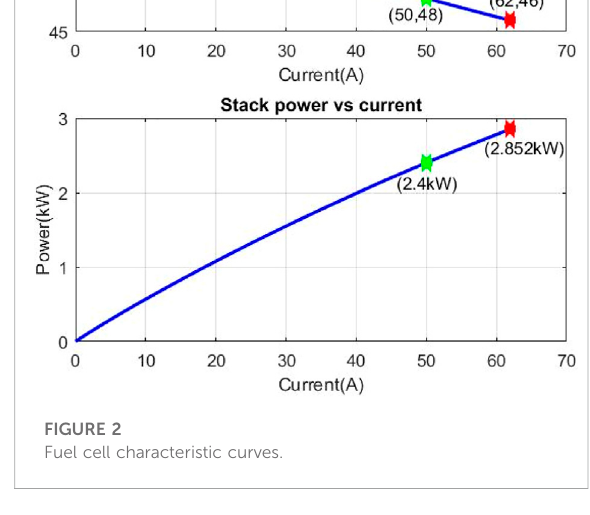
FIGURE 2 Fuel cell characteristic curves.